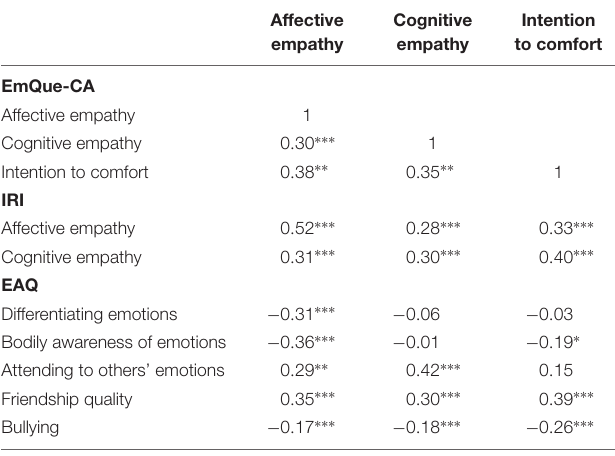
TABLE 5 | Correlations between the scales of the EmQue-CA and the scales of the IRI, EAQ, friendship quality, and